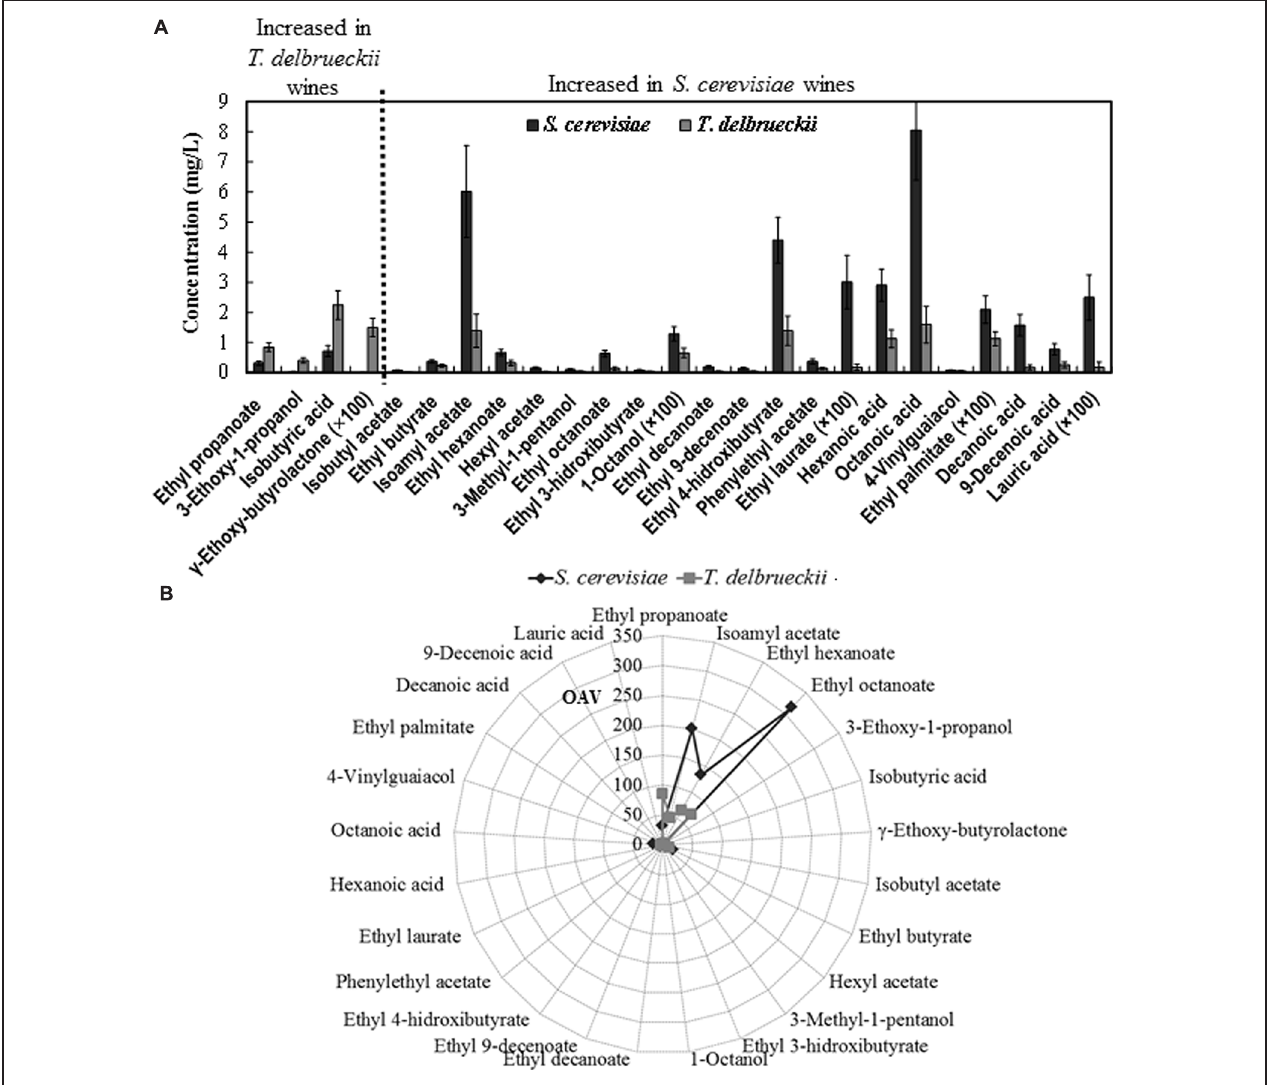
FIGURE 5 | (A) Aromatic compounds from which statistically significant difference ( p < 0.05) were found between the S. cerevisiae- dominated and T. delbrueckii -dominated wines. The data are the mean ± standard error of 23 independent vinifications made in duplicate, 11 inoculated with S. cerevisiae and 12 with T. delbrueckii . (B) Mean values of the odorant activity values (OAV) for the same compounds in S. cerevisiae- dominated and T. delbrueckii- dominated white